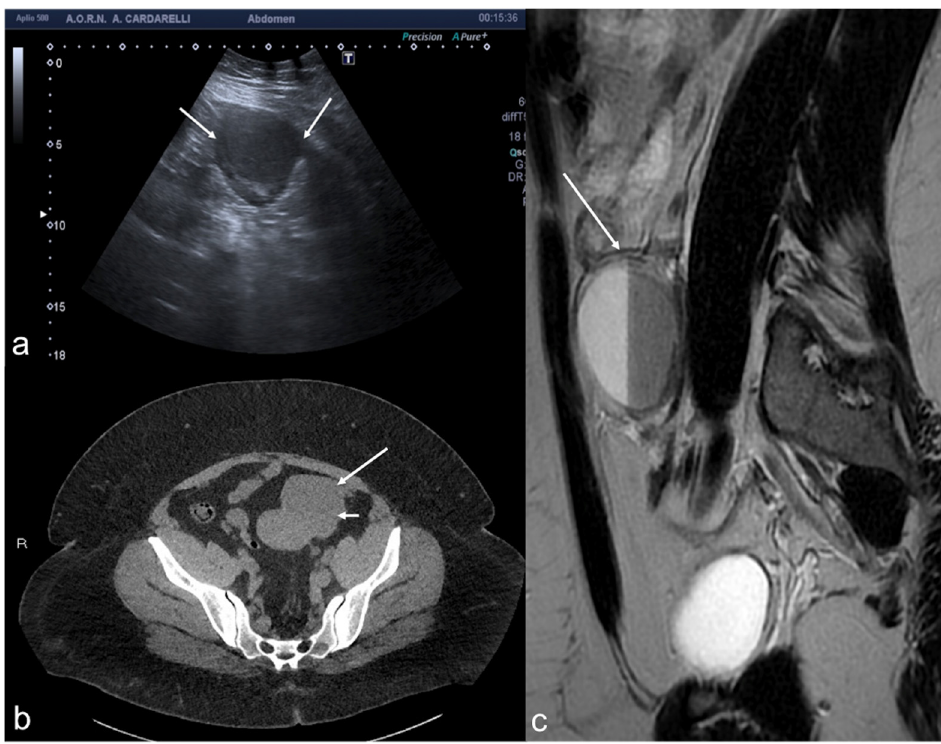
Figure 8. Adnexal endometriomas. TSA–US axial scan ( a ) shows a left adnexal unilocular cyst with acoustic enhancement and diffuse homogeneous ground-glass echoes as a result of the hemorrhagic debris (arrows). On axial unenhanced CT scan, a hypodense mass in the left annex (( b ) long arrow). Note the fluid-thick level (( b ) short arrow). This latter finding appears clearly visible on T2w MRI (( c ) arrow).